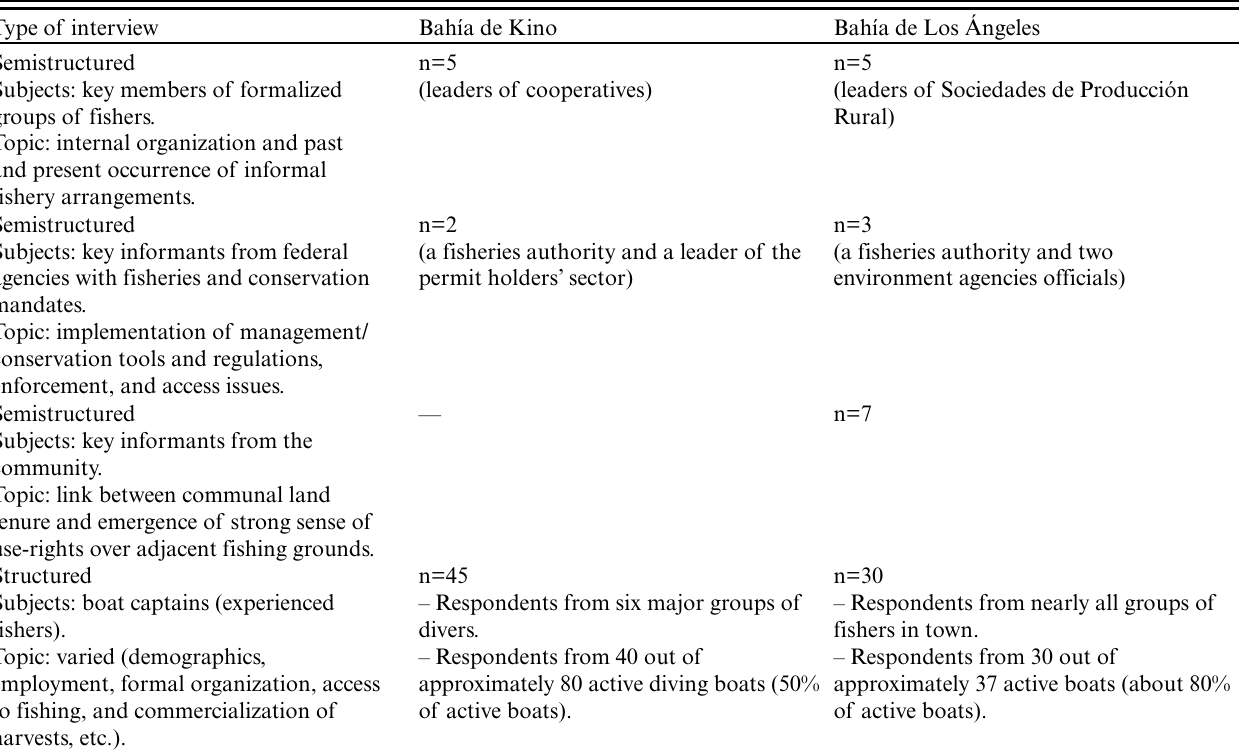
Table 1 . Type and number of interviews conducted in each community. Type of